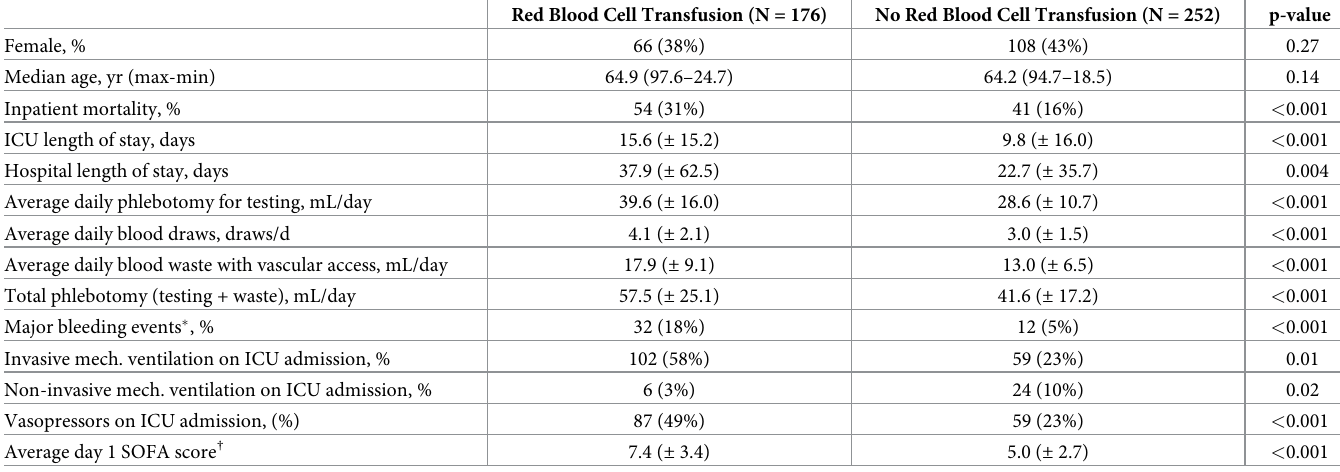
Table 2. Comparison of patients with and without a red blood cell transfusion during their ICU